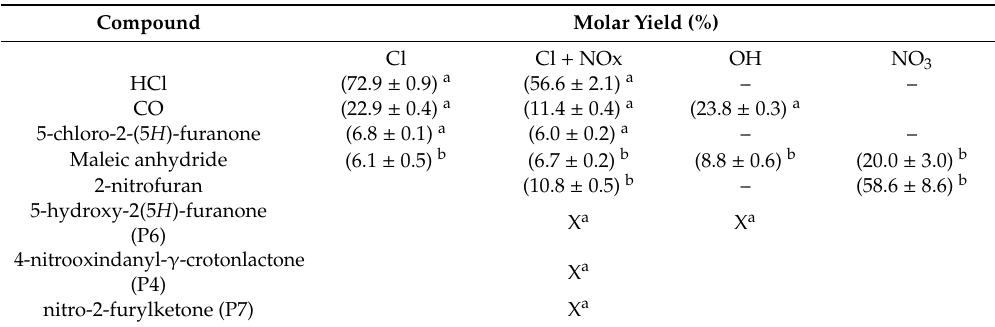
Table 1. Product yields confirmed by FTIR and GC–TOFMS analysis for the reaction of furfural with di ff erent